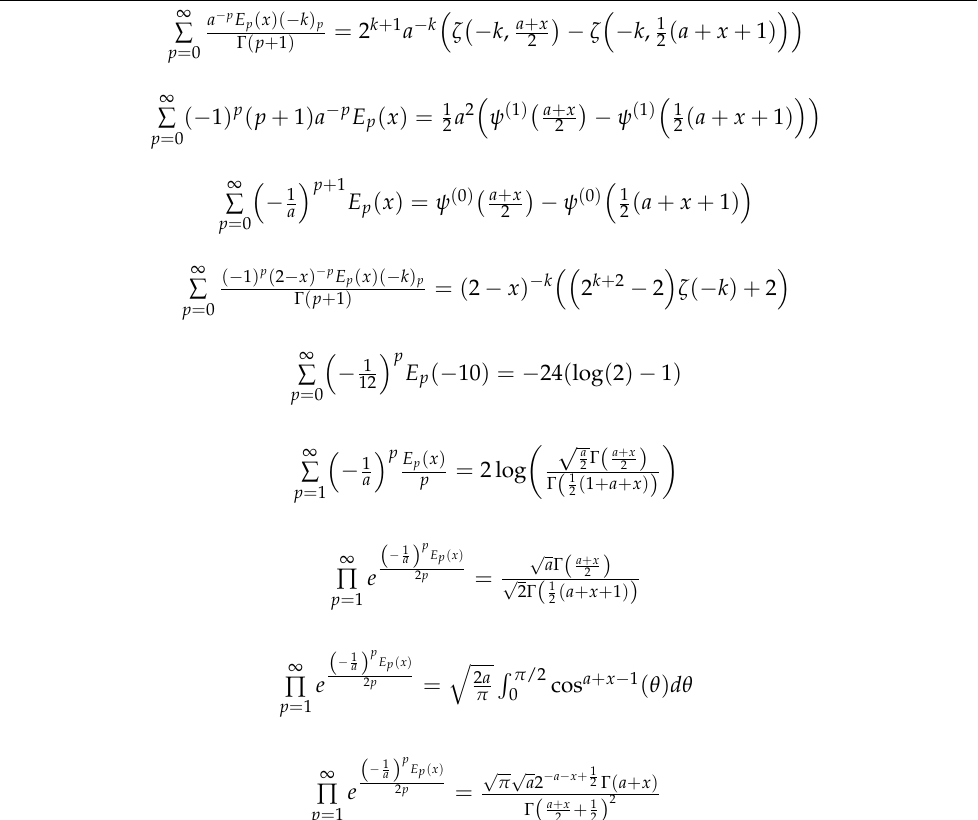
Table 1. Summary Table of